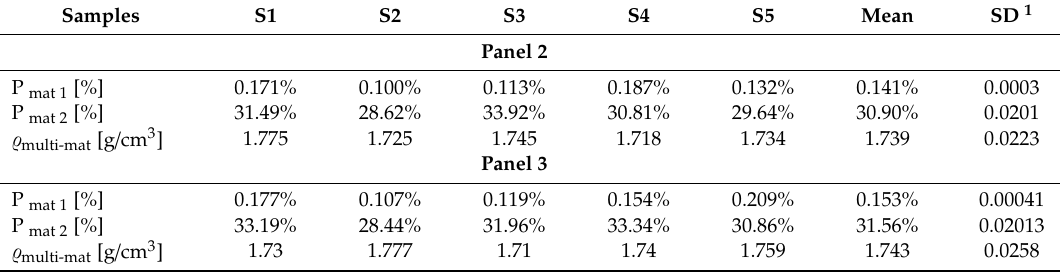
Table 3. Material characterization of panels 2 and